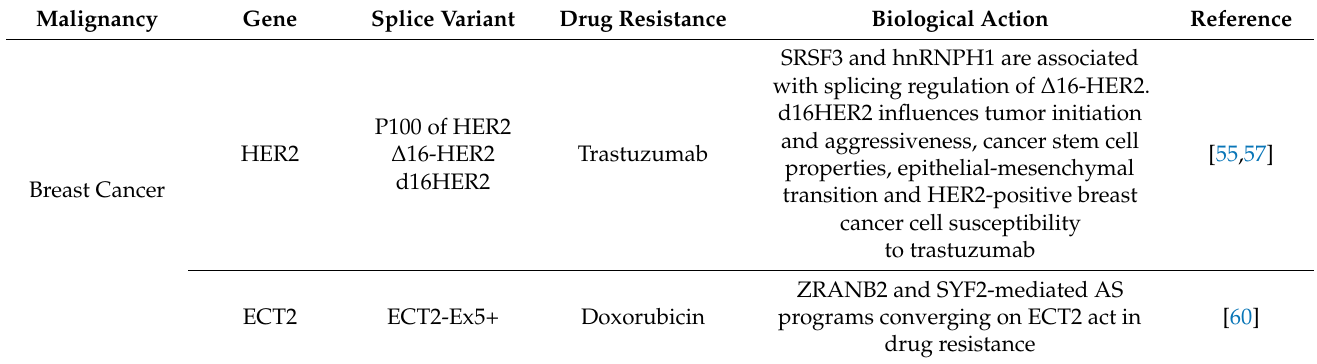
Table 2. AS and effects on drug resistance in breast